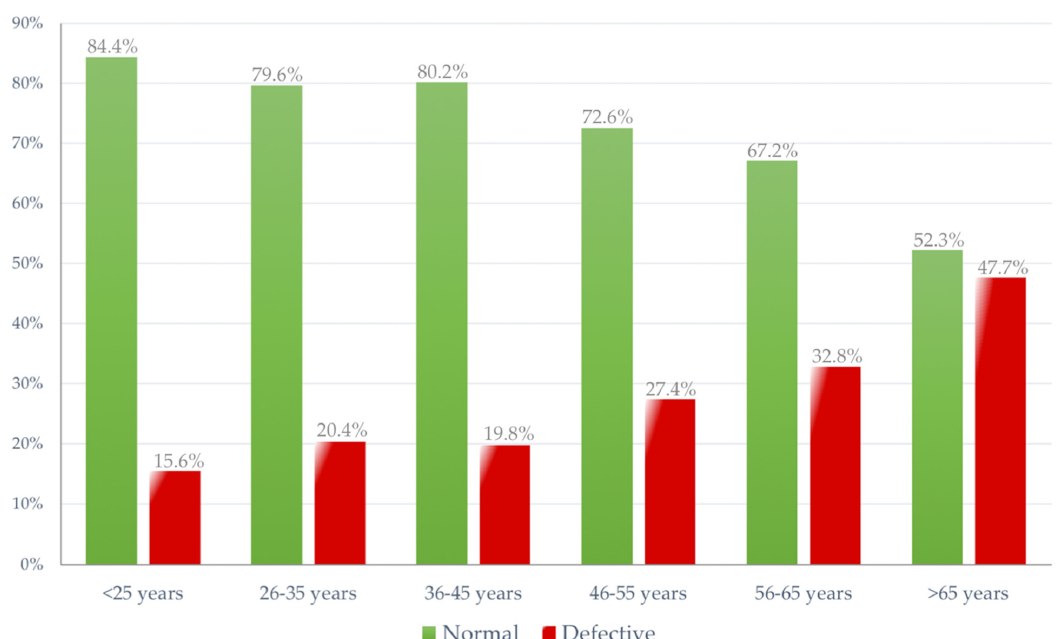
Figure 3. Distribution of normal and deficient cases for visual field screening (80 ◦ campimetry) by age group (percentages).